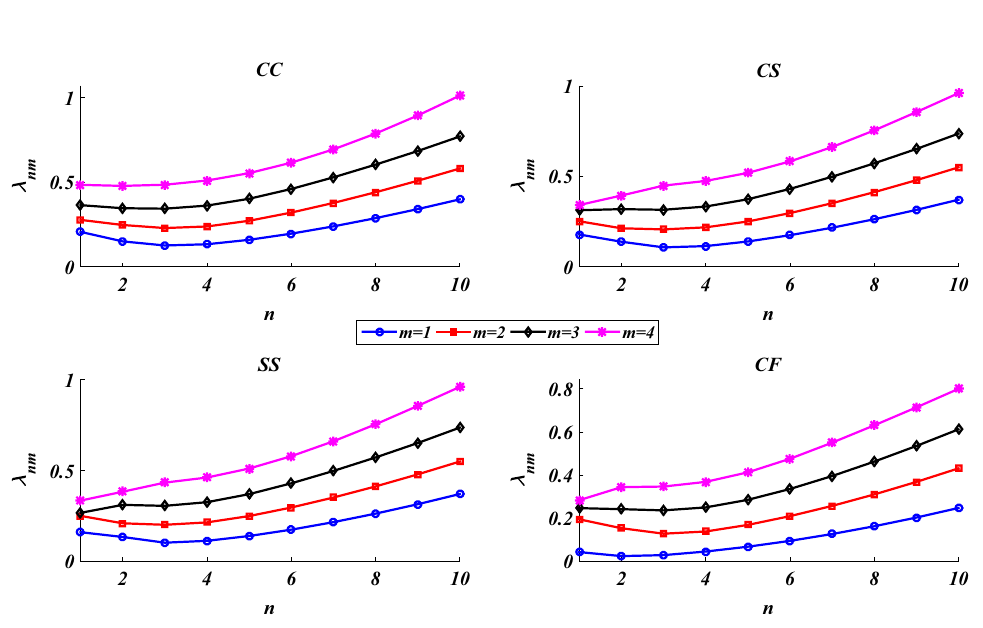
Figure 4. Dependency of the natural frequencies on the circumferential wave